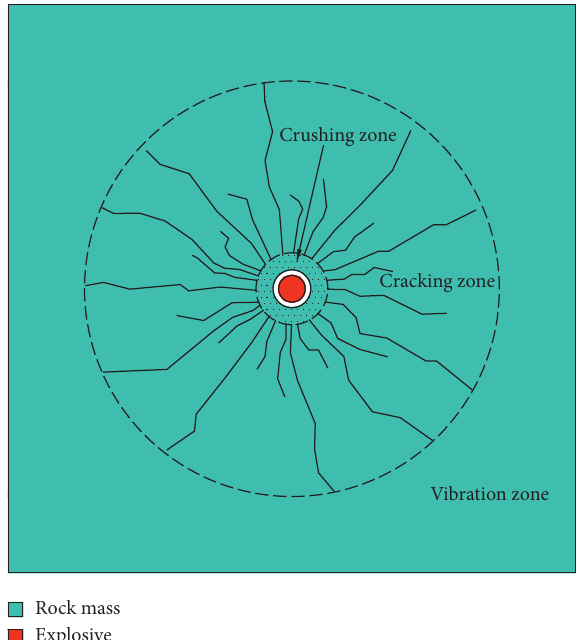
Figure 1: Damage zones around a blast